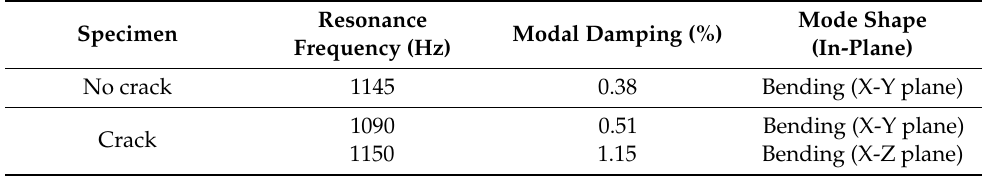
Table 1. Summary of experimental modal analysis for two